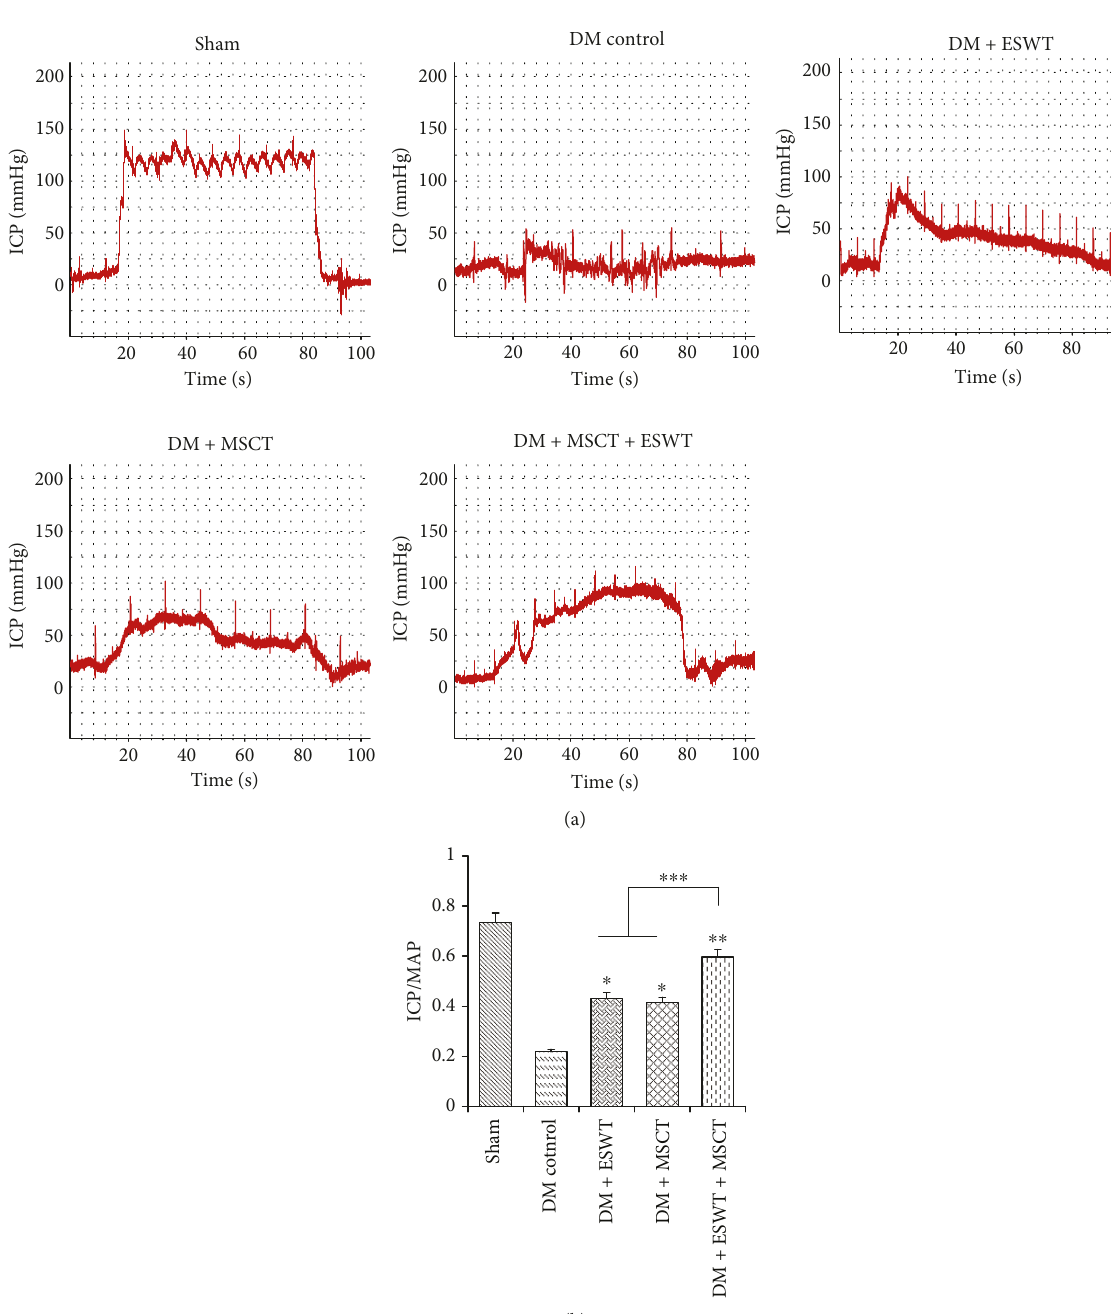
Figure 1: Erectile function of each group. (a) Representative images of intracavernous pressure (ICP) in response to electrical stimulation of the cavernosal nerve. (b) Results of ratio ICP to mean MAP of each group. Each bar shows the mean values (standard deviation). ∗ p < 0 05 compared with DMED rats. ∗∗ p < 0 01 compared with DMED rats. ∗∗∗ p < 0 05 compared with DM+ ESWT and DM +MSCT